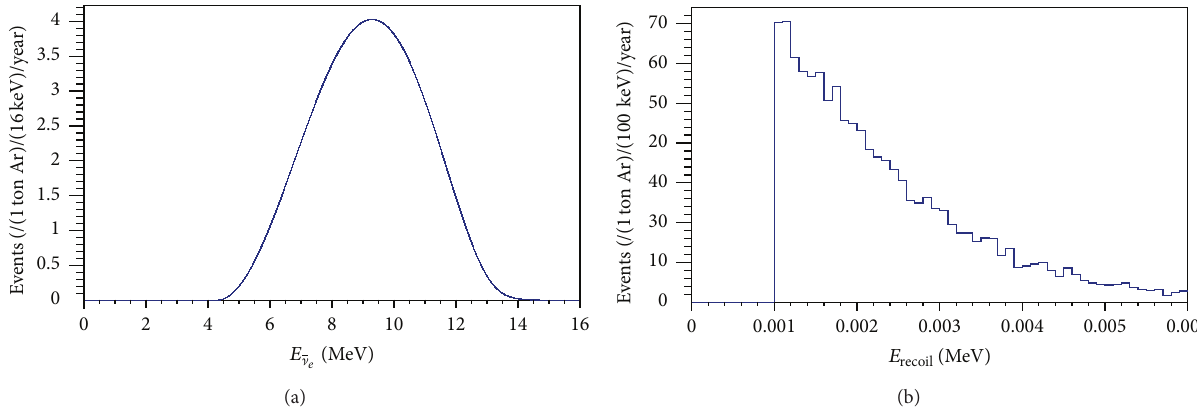
Figure 11: (a) Coherent event rate in terms of antineutrino energy with a 1000kg argon detector at a 10m average baseline from the IsoDAR source. (b) The event rate in terms of nuclear recoil